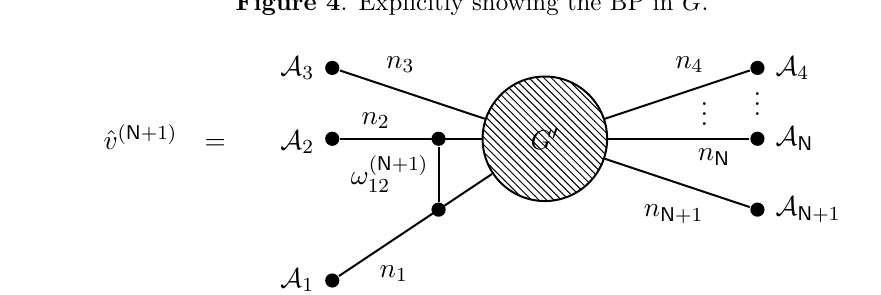
Figure 4 . Explicitly showing the BP in G .